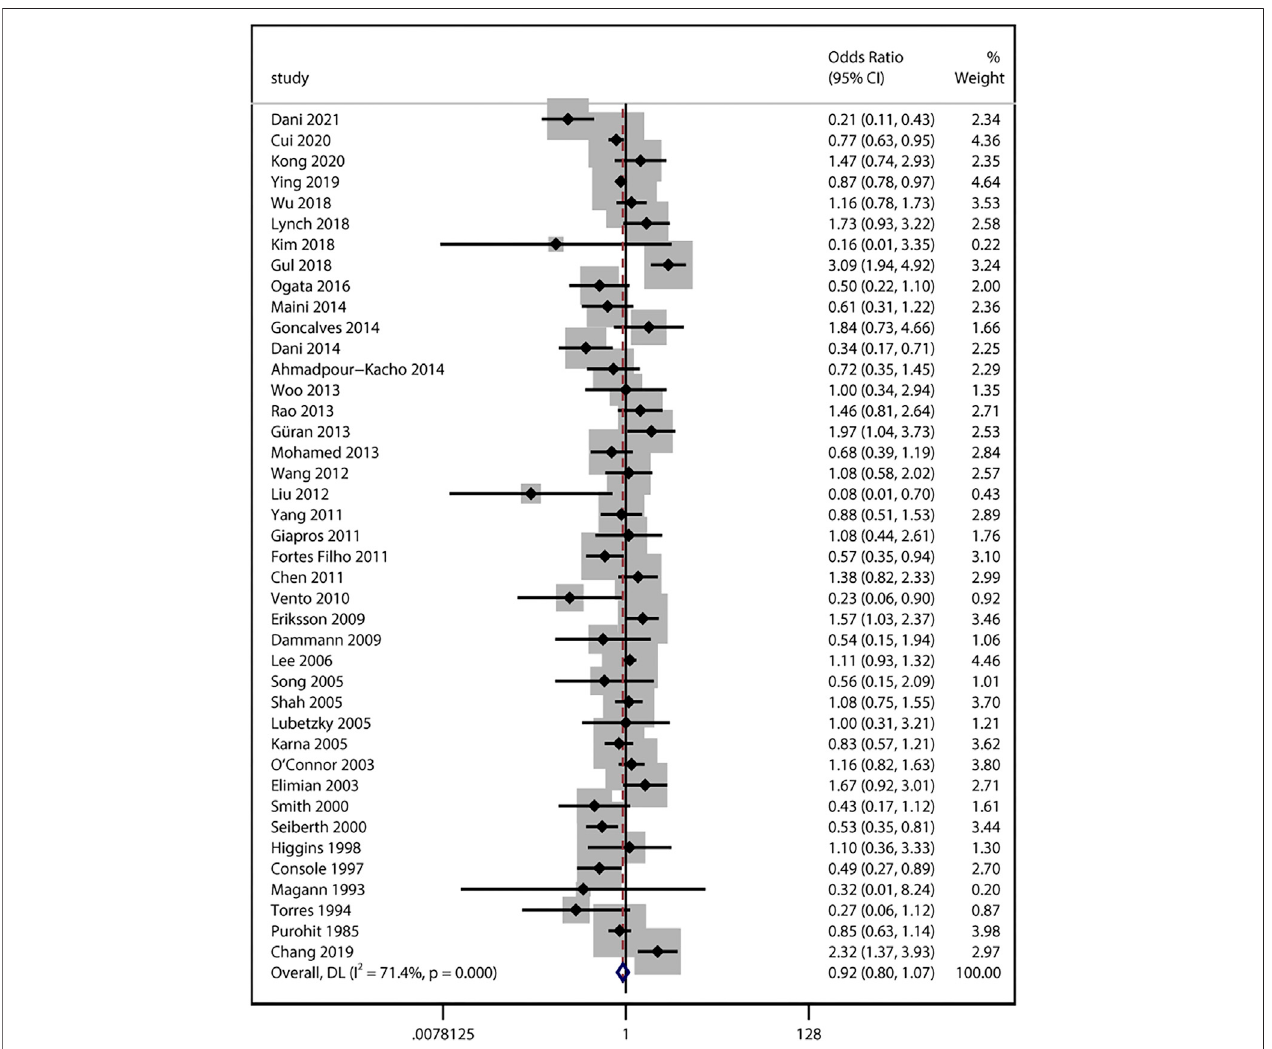
FIGURE 2 | Meta-analysis of unadjusted ORs and 95% CIs for the association between antenatal corticosteroids exposure and any stage of retinopathy of prematurity.